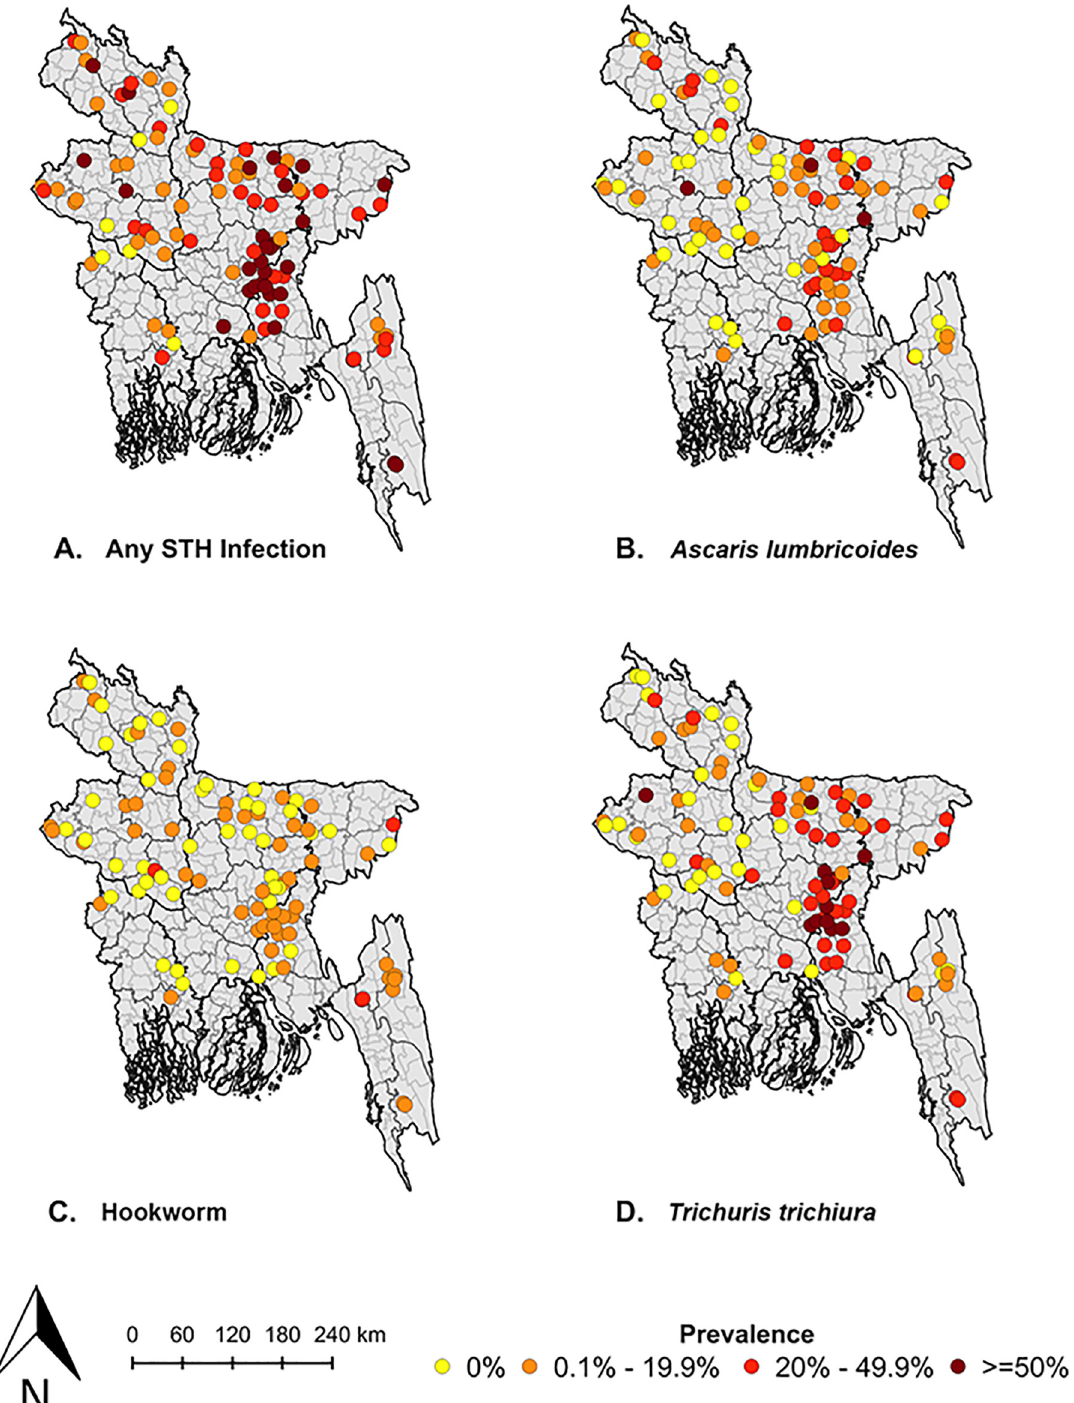
Fig 2. Map of soil-transmitted helminth prevalence in Bangladesh. We mapped STH prevalence in each study cluster for which valid GPS coordinates were available (n = 99). Panel A shows the cluster-level prevalence of any STH infection, Panel B shows the prevalence of Ascaris lumbricoides , Panel C shows the prevalence of hookworm, and Panel D shows the prevalence of Trichuris trichiura